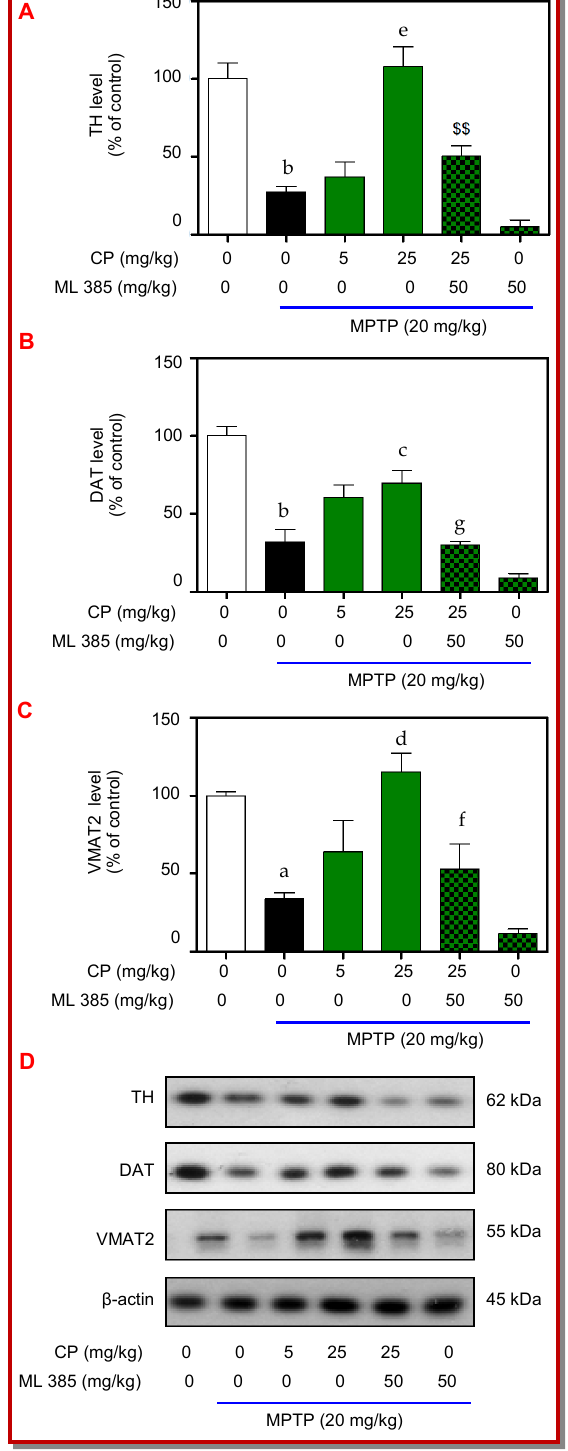
Figure 5: Nuclear factor E2-related factor 2 (Nrf2) inhibition neutralizes the protective effect of Cicadidae Periostracum (CP) fol- lowing 1-methyl-4-phenyl-1,2,3,6-tetrahydropyridine (MPTP) treatment in vivo. The Nrf2 inhibitor, ML385 (50 mg/kg), or saline were injected intraperitoneally once daily 30 min before CP treatment in the MPTP intoxication model. Seven days after the last MPTP treatment, the expression levels of (A) tyrosine hydroxylase (TH), (B) dopamine transporter (DAT), and (C) vesicular mono- amine transporter 2 (VMAT2) in the substantia nigra pars compacta were measured by Western blotting. Dopamine levels were measured using an enzyme-linked immunosorbent assay. (D) Representative Western blot. a p<0.01 and b p<0.001 compared with the control group; c p<0.05, d p<0.01, and e p<0.001 compared with the MPTP-treated group; f p<0.05 and g p<0.01 compared with